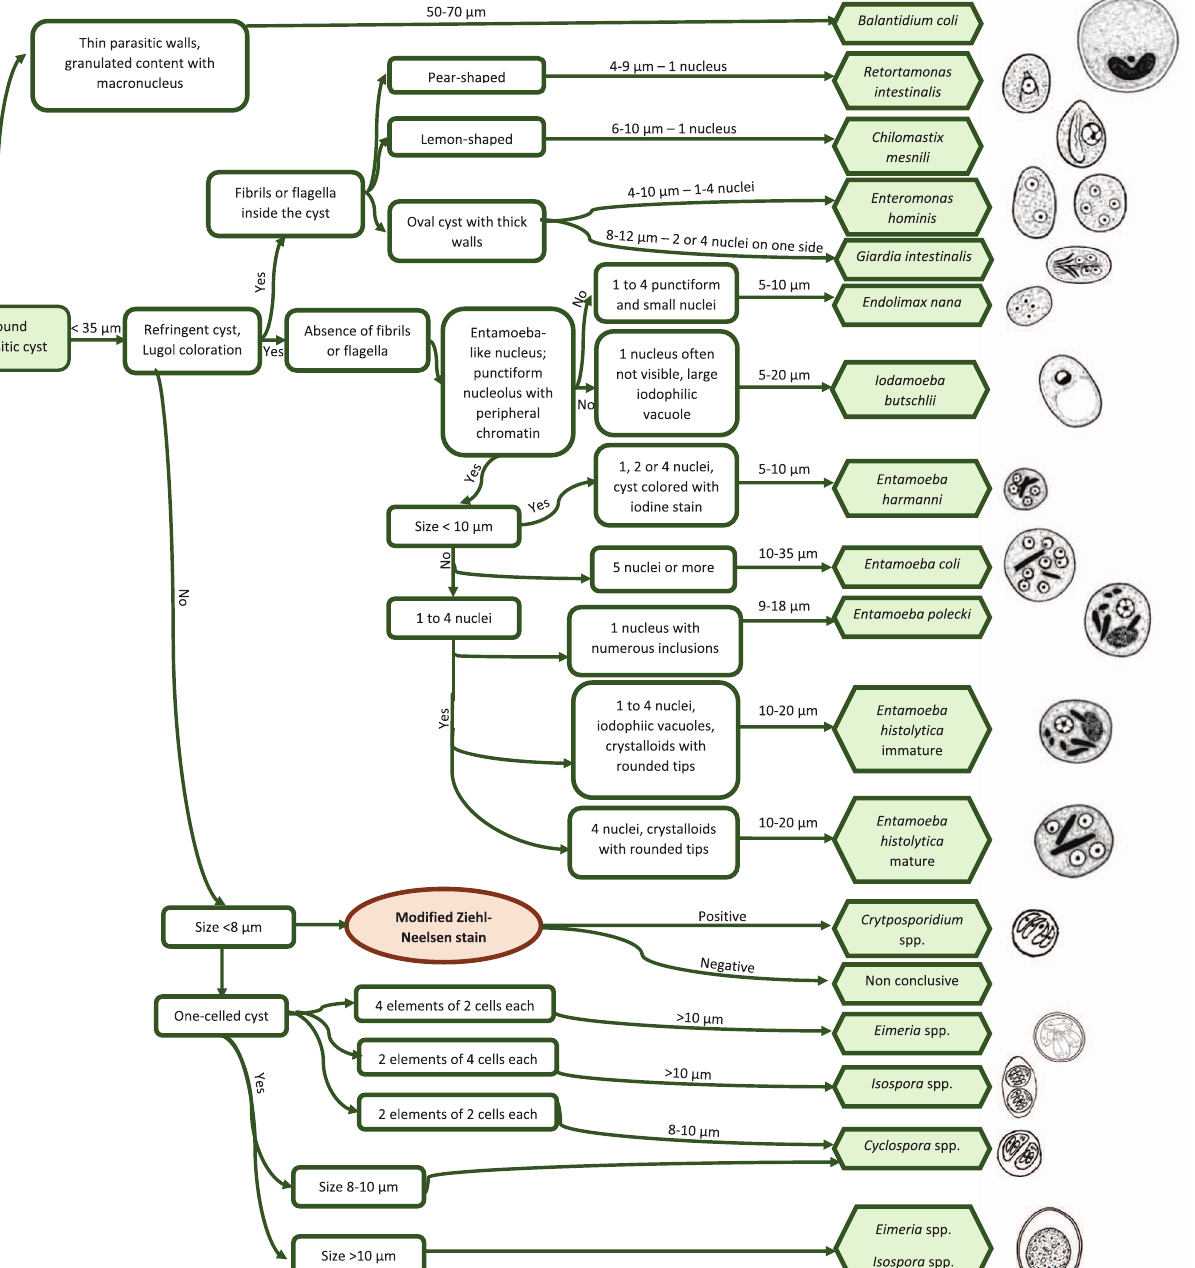
Figure 3. Decision-making tree for the diagnosis of protozoa in non-human